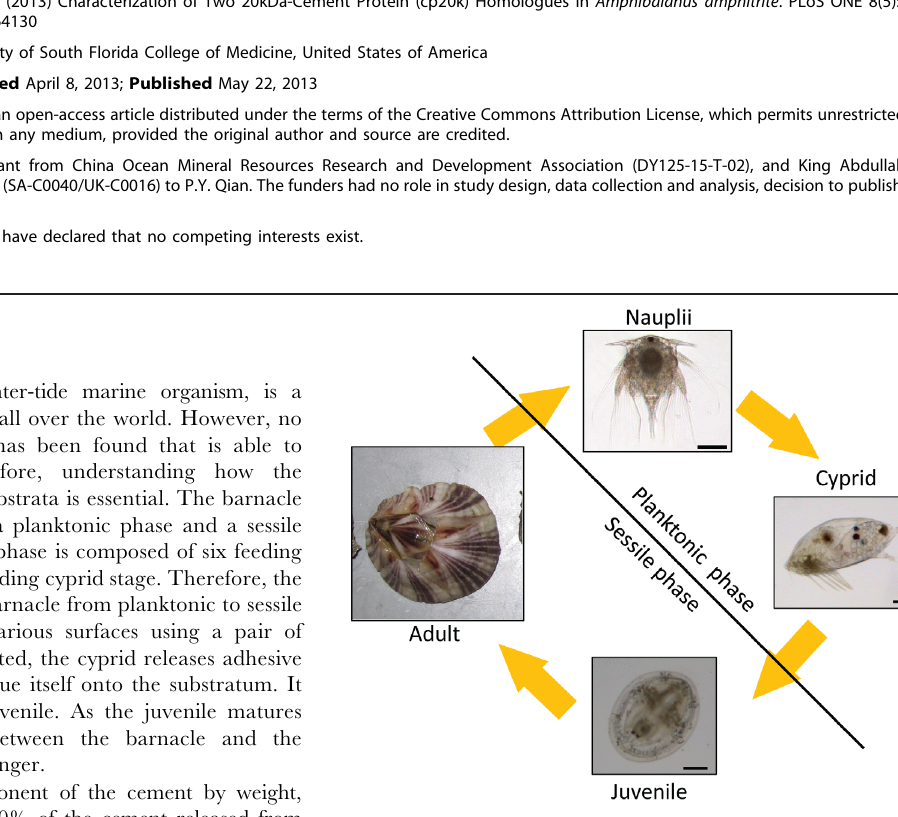
Figure 1. Life cycle of Amphibalanusamphitrite . The life cycle of barnacle is composed of two distinct phases: planktonic phase and sessile phase. The planktonic phase includes six feeding nauplius stages and one non-feeding cyprid stage; the sessile phase includes a juvenile and adult stages. Scale bar: 100 m m.